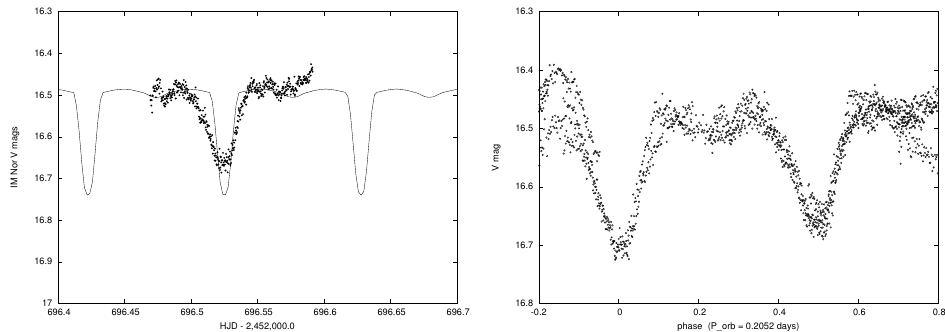
Figure 1. ( Left ) panel: A model eclipse light curve (stars + disk + (cid:96) 3 ) for WW’s orbital period P = 0. d 1026 and inclination 83 ◦ , compared with the light curve for WW’s first night (dots). Star 2 (donor star) accurately fills its limiting lobe. Excessive width of the observed eclipse is obvious, with no parameter adjustments being sufficient to correct the gross mismatch. The disk is sufficiently thick to produce complete eclipses of star 2, and the disk’s temperature has been raised to make it about 5 m brighter in V band than the un-irradiated side of star 2. The panel quantifies WW’s comments that the observed dips are too wide to be eclipses (if neither Resolution I nor Resolution II of this paper is considered). ( Right ) panel: WW’s nights 1, 2, and 3 plotted together, phased on the doubled period 0. d 2052 (by Resolution I’s hypothesis, the true orbit period) so readers can judge whether the depths and shapes of even and odd numbered dips are the same or differ. Figures 2 and 3 also are for P orb = 0. d 2052 and include theoretical model curves so as to test whether a doubled period solves the eclipse width problem.